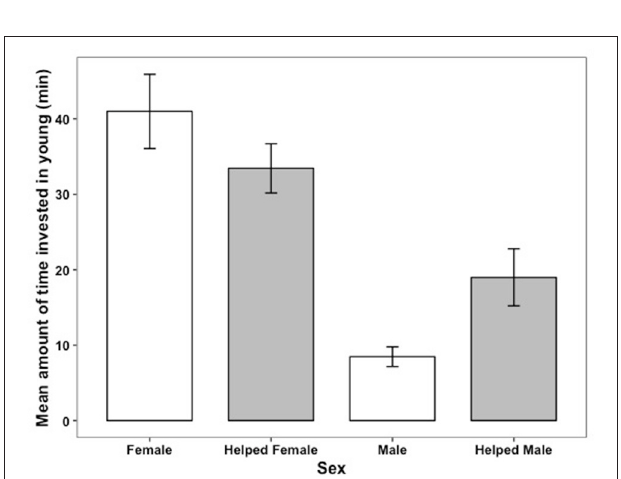
FIGURE 5 | The relationship between how much time parents invested in young and whether they received help (shown in gray) during an observation session. Error bars generated with ± S.E. of the mean.